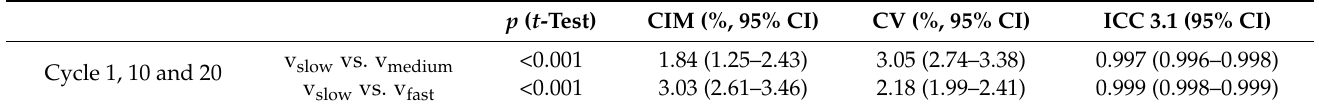
Table 2. Analysis of the reliability of the instruments of the sensor system in respect of different deformation velocities.